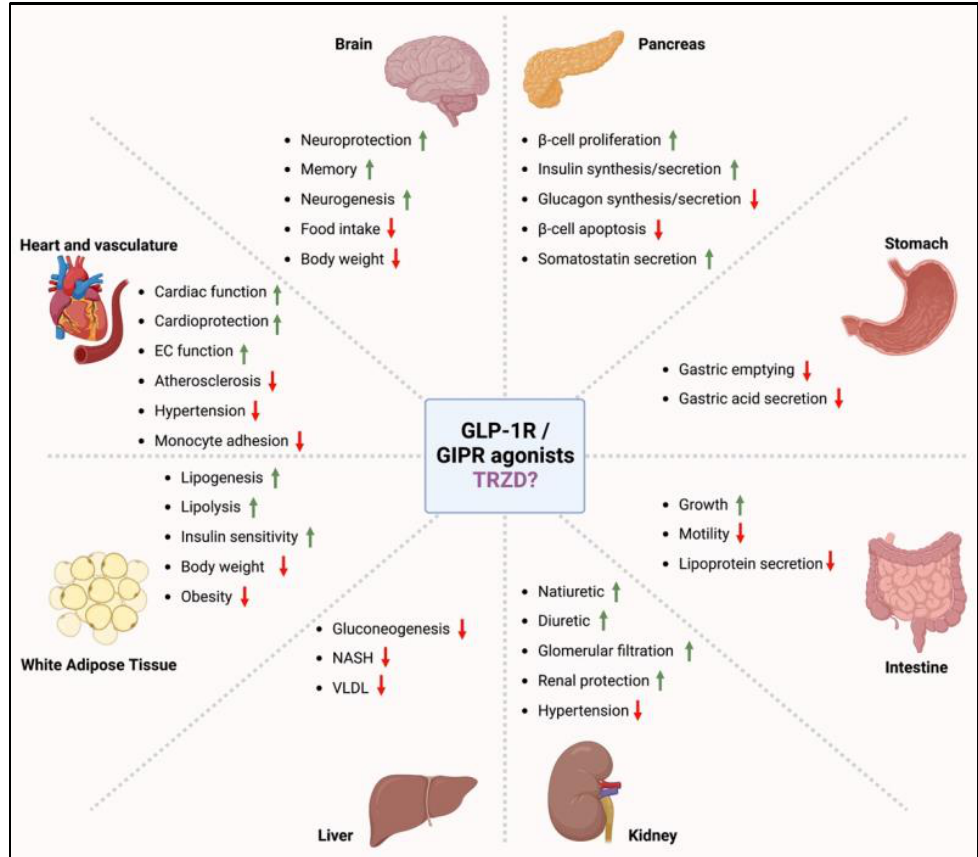
Figure 1. Possible target sites of GLP-1R/GIPR agonists and possibly TRZD. The incretin hormones GLP-1 and GIP secreted by the gastrointestinal tract have a wide array of target tissue that modulate various organ system functions. GLP-1R/GIPR agonists and possibly TRZD play several beneficial and protective functions in the various organ systems. The green upward arrow indicates increase/activation, while the red downward arrow indicates decrease/inhibition. EC = endothelial cell, NASH = non-alcoholic steatohepatitis and VLDL = very low-density lipoprotein. Created with Biorender.com (accessed on 14 September 2022).